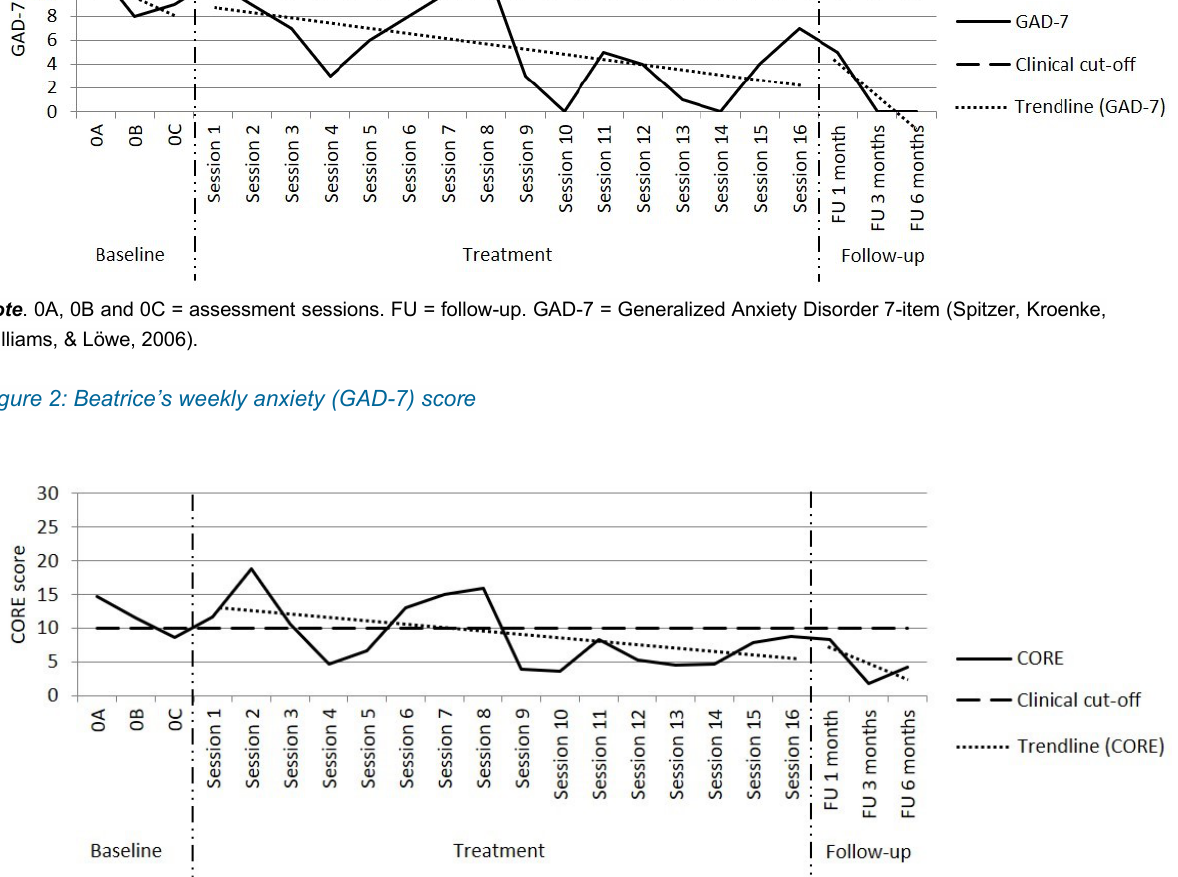
Note . 0A, 0B and 0C = assessment sessions. FU = follow-up. CORE = Clinical Outcomes in Routine Evaluation-Outcome Measure (Evans et al., 2002). Figure 3: Beatrice’s weekly global distress (CORE) score